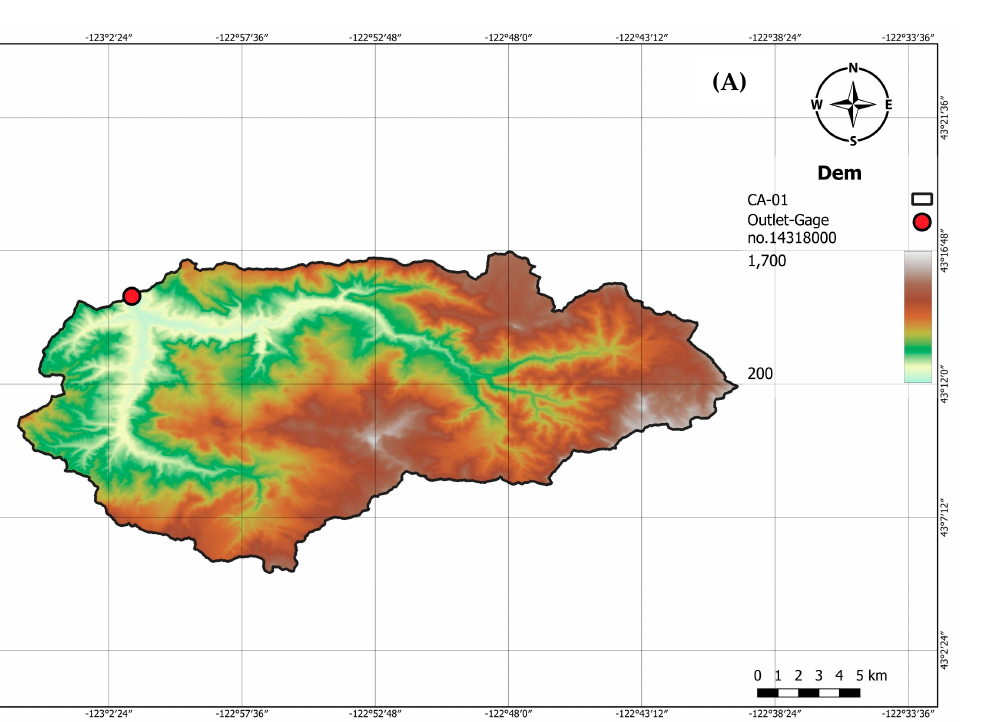
Table 7. All rainfall and runoff data were extracted from StreamStats, except the 100-year return period rainfall data for some of the catchments, which were extracted from NOAA Atlas 14. All catchments’ data were found in both data sources (USGS-StreamStats and NOAA Atlas 14), but no rainfall data were found covering CA-01, CA-02, or CA-03 in the 100-year return period.